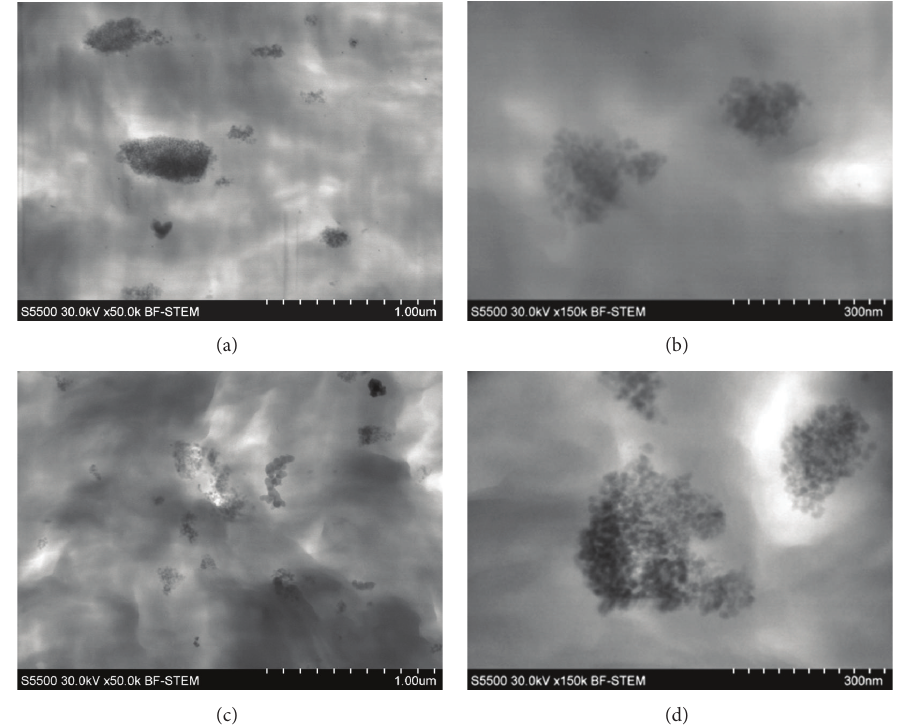
Figure 4: TEM images of HDPE/Ag-SiO 2 composites: 10wt.% Ag-SiO 2 ((a), (b)), 15wt.% Ag-SiO 2 ((c),